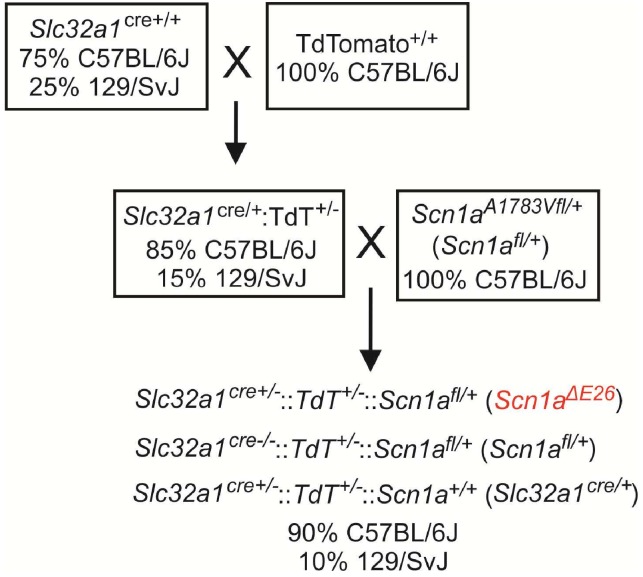
Breeding strategy to generate mice that heterologously express the Scn1a A1783V pathological variant conditionally in inhibitory neurons (Scn1aΔE26 mice).Homozygous Gt(ROSA)26Sortm14(CAG-tdTomato)Hze/J reporter mice (Ai14; JAX no. 007914) on a 100% C57BL/6J background are bred with mice that express Cre recombinase targeted to Slc32a1, the gene encoding Vgat (Slc32a1Cre mice, JAX no. 016962), on a mixed background of 75%::25% C57BL/6J::129/SvJ to produce Slc32a1Cre:: TdT double-heterozygous mice with a 85% C57BL6/J: : 15% 129/SvJ background. These mice are then bred with Scn1aA1783Vfl/+ (JAX no. 026133) maintained on a 100% C57BL/6J background to produce experimental animals with a genotype of Slc32a1cre+/-::TdT+/-::Scn1afl/+ (Scn1aΔE26) and control animals of the following genotypes Slc32a1cre-/-::TdT+/-::Scn1afl/+ (Scn1afl/+) and Slc32a1cre+/-::TdT+/-::Scn1a+/+ (Slc32a1cre/+). Experimental and control mice had a common background of 90% C57BL6/J: : 10% 129/SvJ. The proportion of each background stain was determined by Genome scan analysis (JAX).